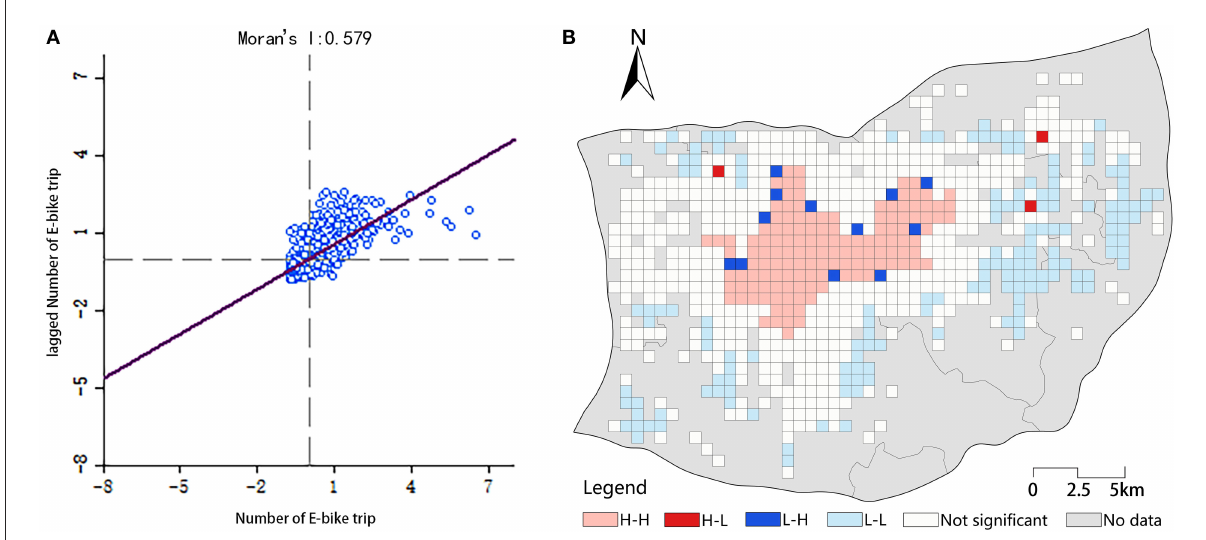
FIGURE4 Spatial distribution pattern. (A) Moran scatterplot. (B) Local Moran’s I clusters of e-bike trips.